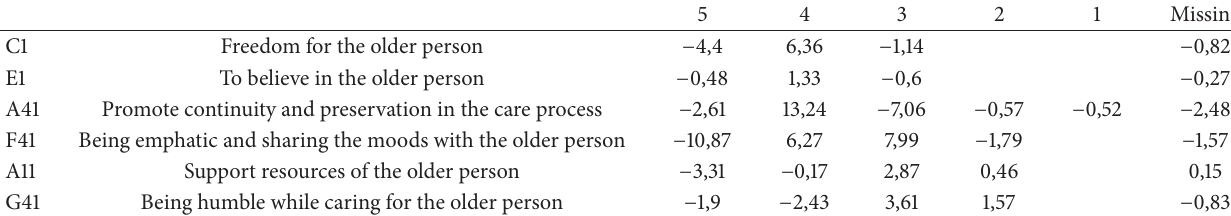
Table 12: Effects on distribution function when D41 fixed to “3” = 100%.